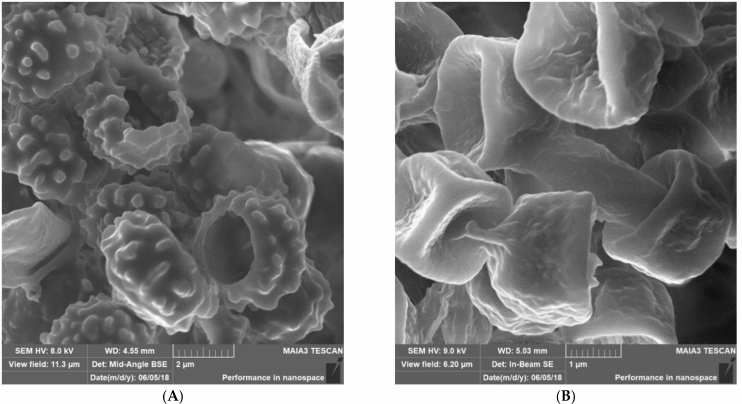
Figure 3. Differences in spore morphology. ( A )— Aspergilus niger ( B )— Aspergilus flavus